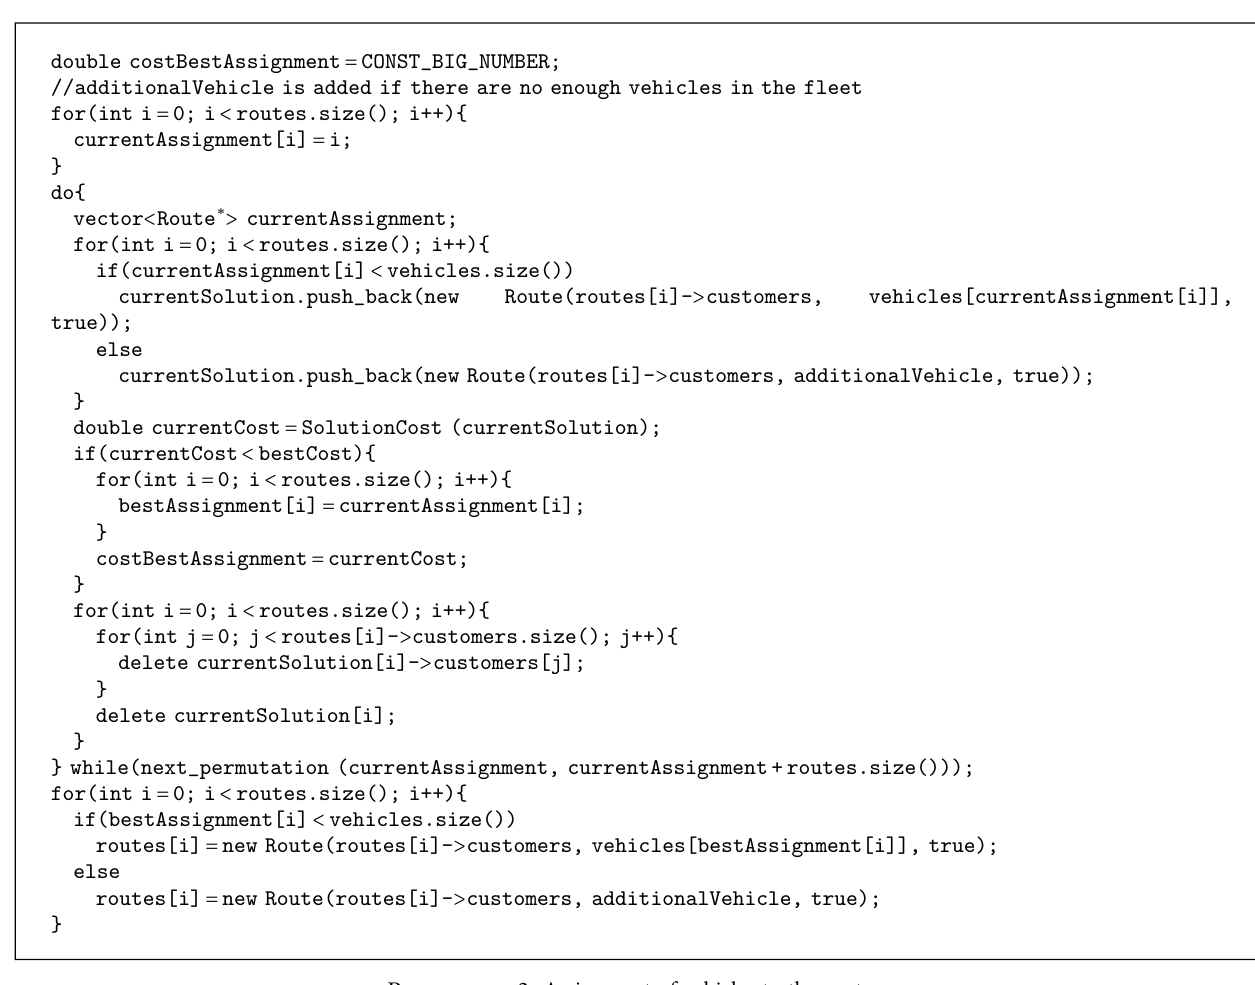
P SEUDOCODE 3: Assignment of vehicles to the